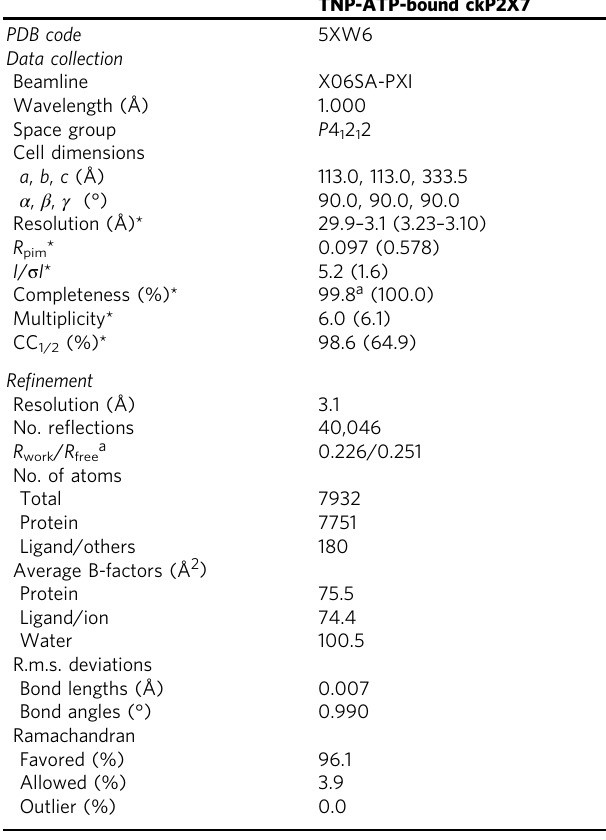
Table 1 Data collection and re fi nement